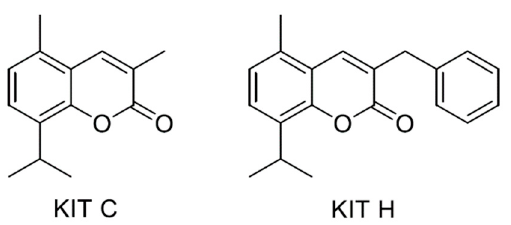
Figure 7. Molecular structure of the synthesized compounds KIT C and KIT H.